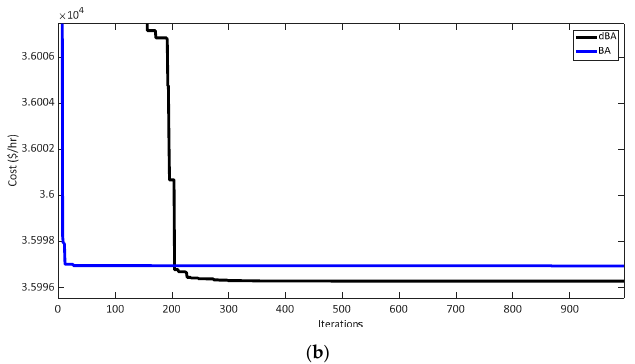
Figure 15. Convergence curve: ( a ) The cost convergence curve by the BA and dBA (15-unit system with renewables); ( b ) Magnified view.